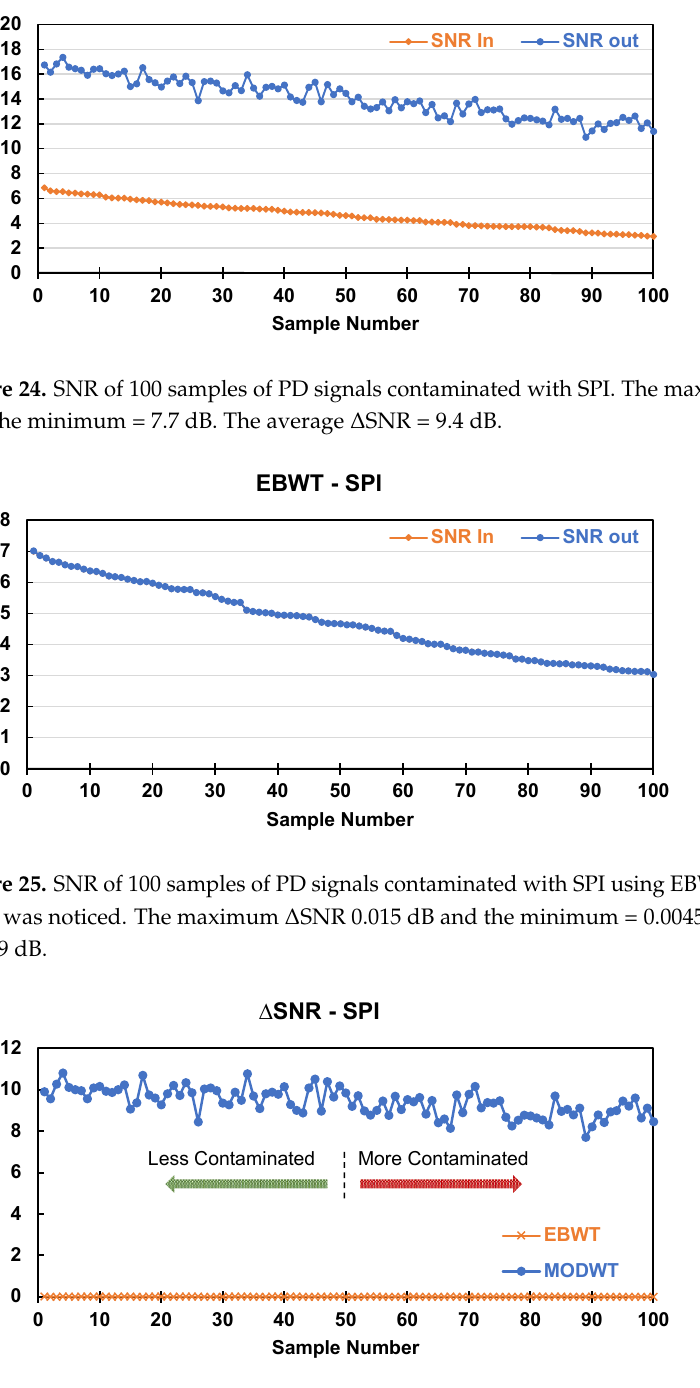
Figure 26. ∆ SNR for both the MODWT and the EBWT methods. The MODWT-based algorithm showed a clear lead in denoising SPI, whereas the EBWT had almost no effect on the noisy signal. Average ∆ SNR for both the MODWT and the EBWT were 9.41 dB and 0.01 dB,